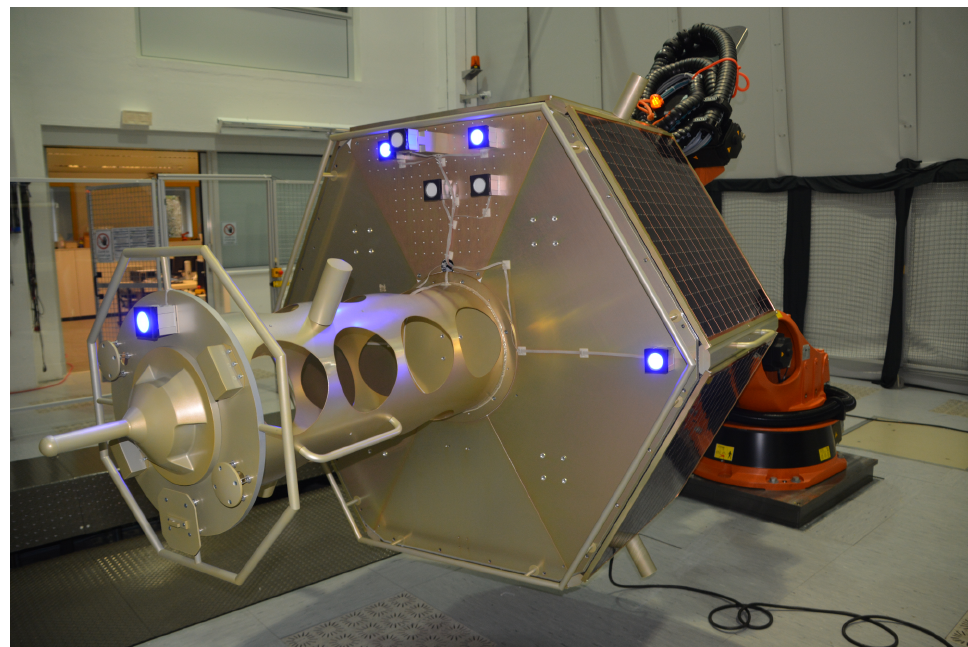
Figure 10. DEOS target mock up without MLI.